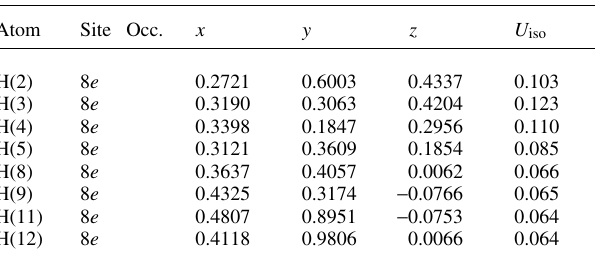
Table 2. Atomic coordinates and displacement parameters (in Å 2 ) . Table 2. Continued